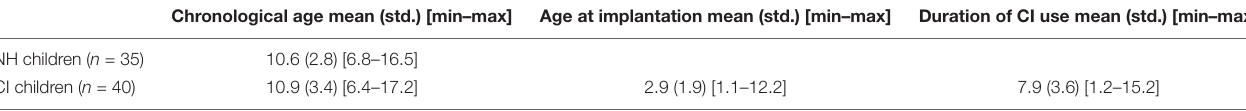
TABLE 1 | Demographics of the two populations of children, who had normal hearing or were wearing a cochlear implant. Chronological age mean (std.) [min–max] Age at implantation mean (std.) [min–max] Duration of CI use mean (std.)